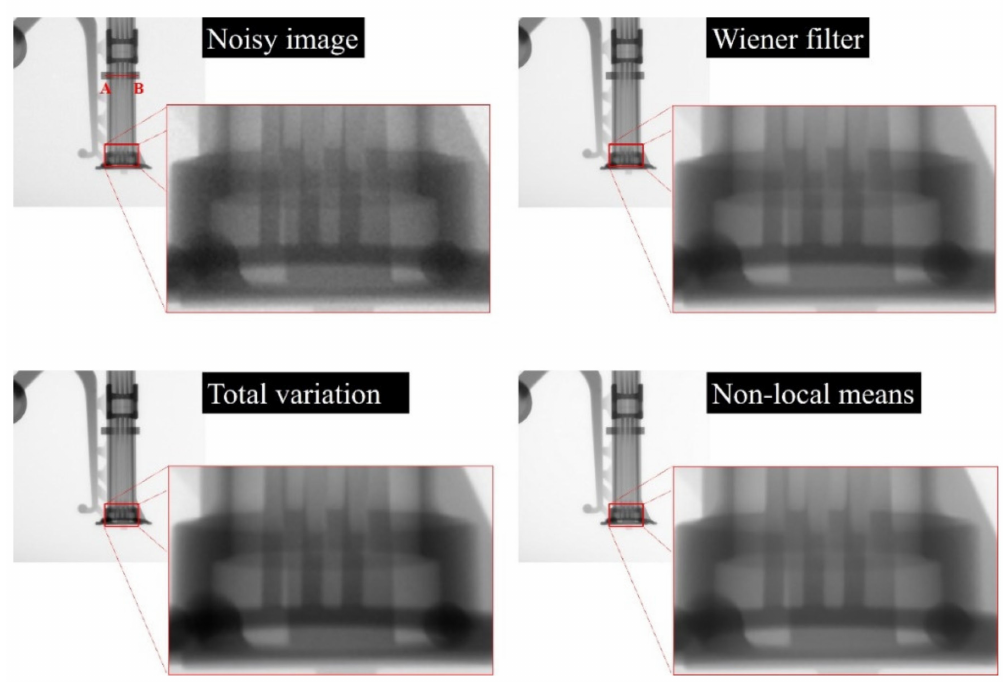
Figure 5. Images of the aluminum die-casting phantom: noisy, Wiener filter, total variation, and proposed non-local means denoising algorithm, acquired with our established industrial high-energy X-ray imaging system. A magnification of a selected region is shown for visual